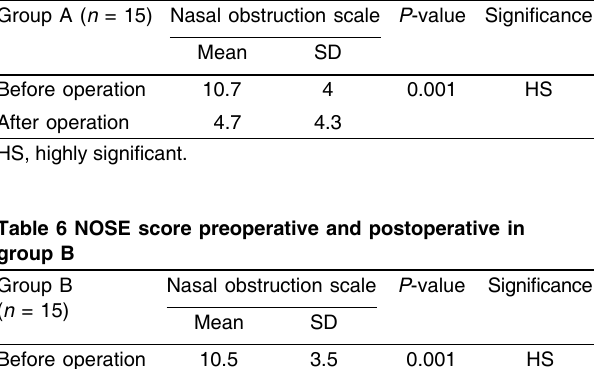
Table 5 NOSE score preoperative and postoperative in group A